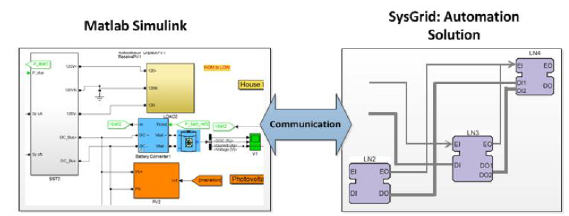
Figure 3. Co-Simulation Environment for validating the generated function block control system.